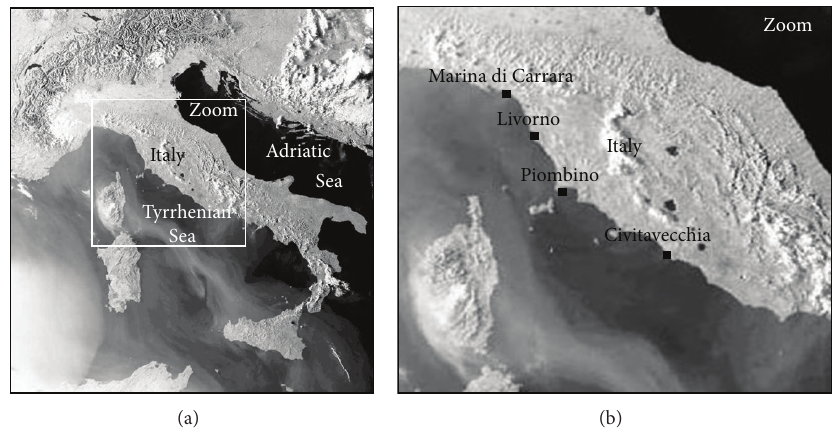
Figure 5: North Tyrrhenian Sea map with analyzed harbor localizations.